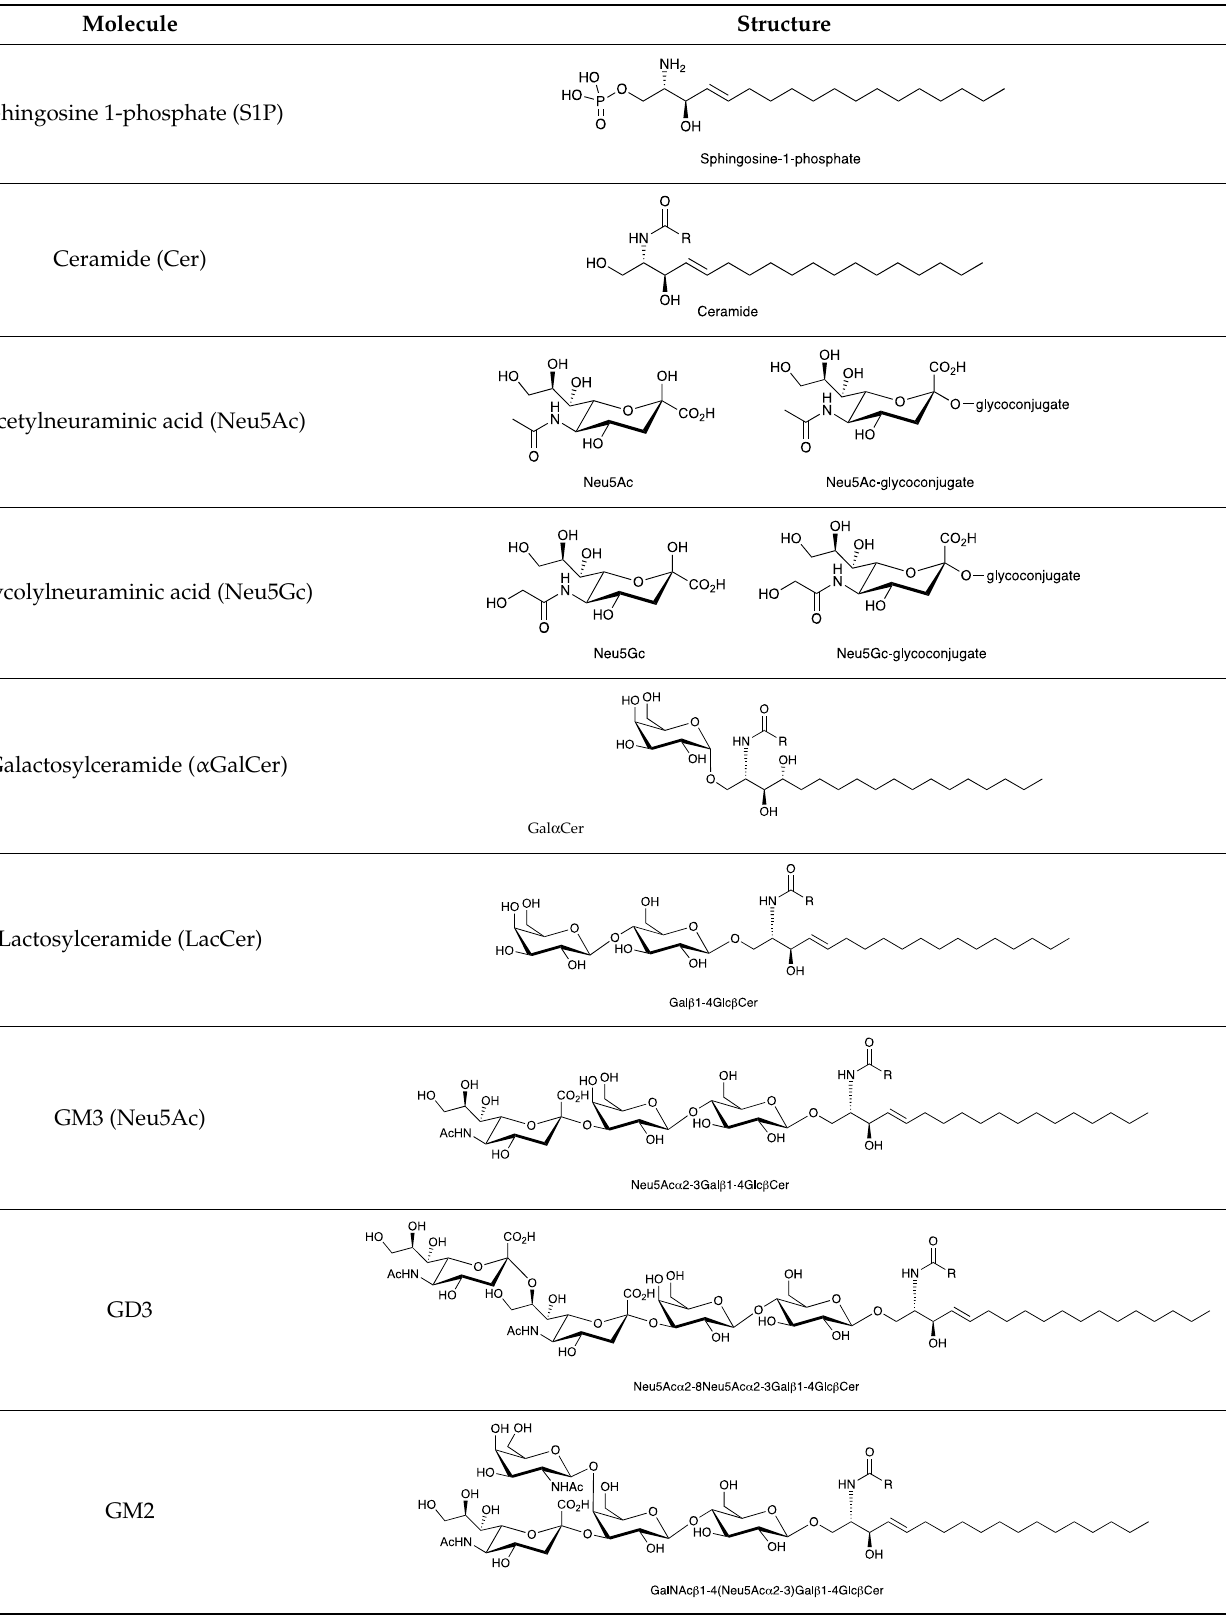
Table 1. Structures of sphingosine 1-phosphate, ceramide, and neutral and sialylated glycosphingolipids referred to in the text.